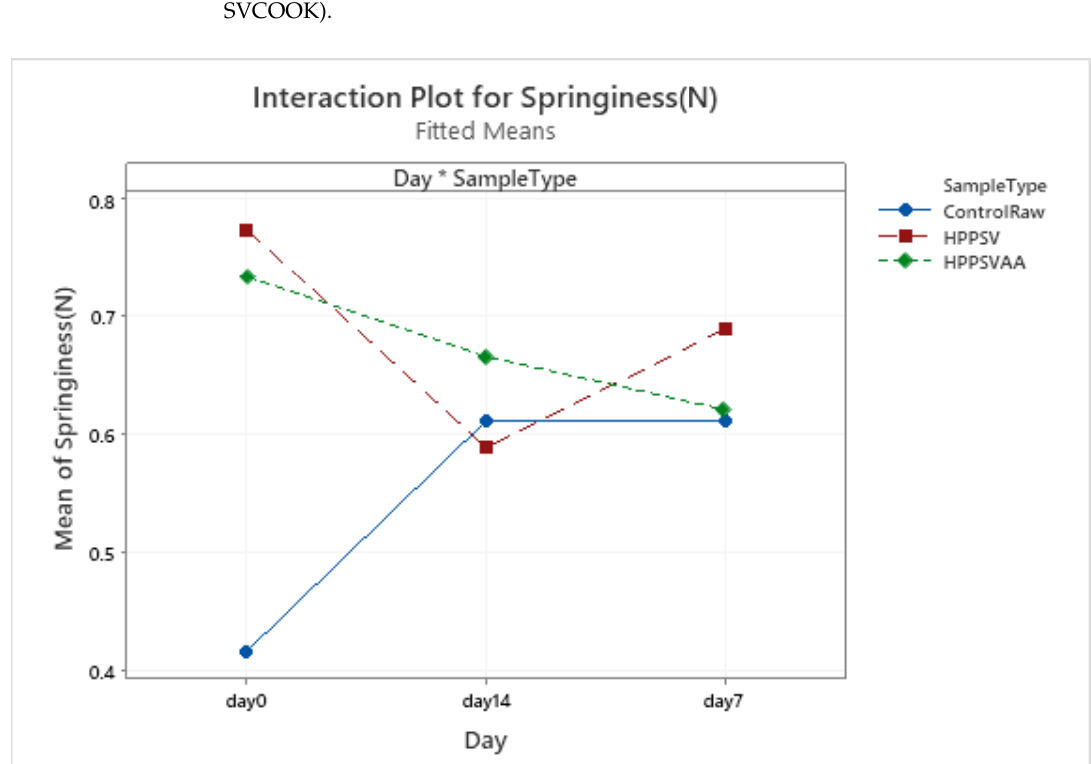
Figure A2. Effect of treatments and storage time on the springiness of veal patty (HPPSV: HPP- SVCOOK).